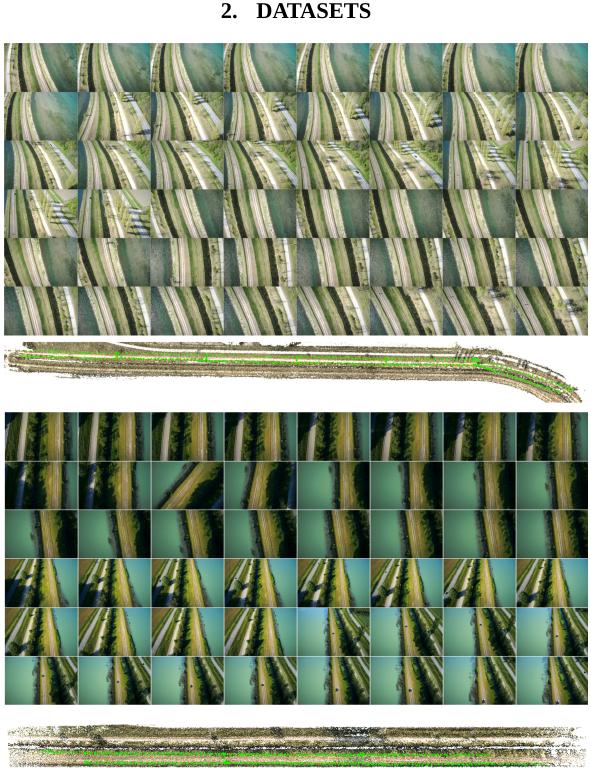
Figure 1: Both datasets are made of a mix of vertical and oblique images, acquired on two parallel strips. 2015 acquisition (up) overlaps the 2014